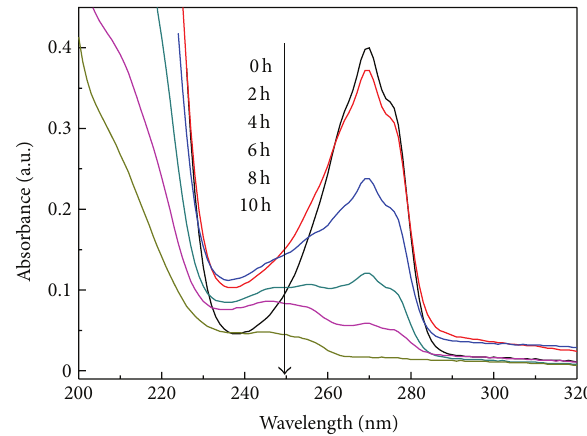
Figure7:EffectofpHvalueonthephotodegradationofphenolwith 0.25 g N-TiO 2 powders.